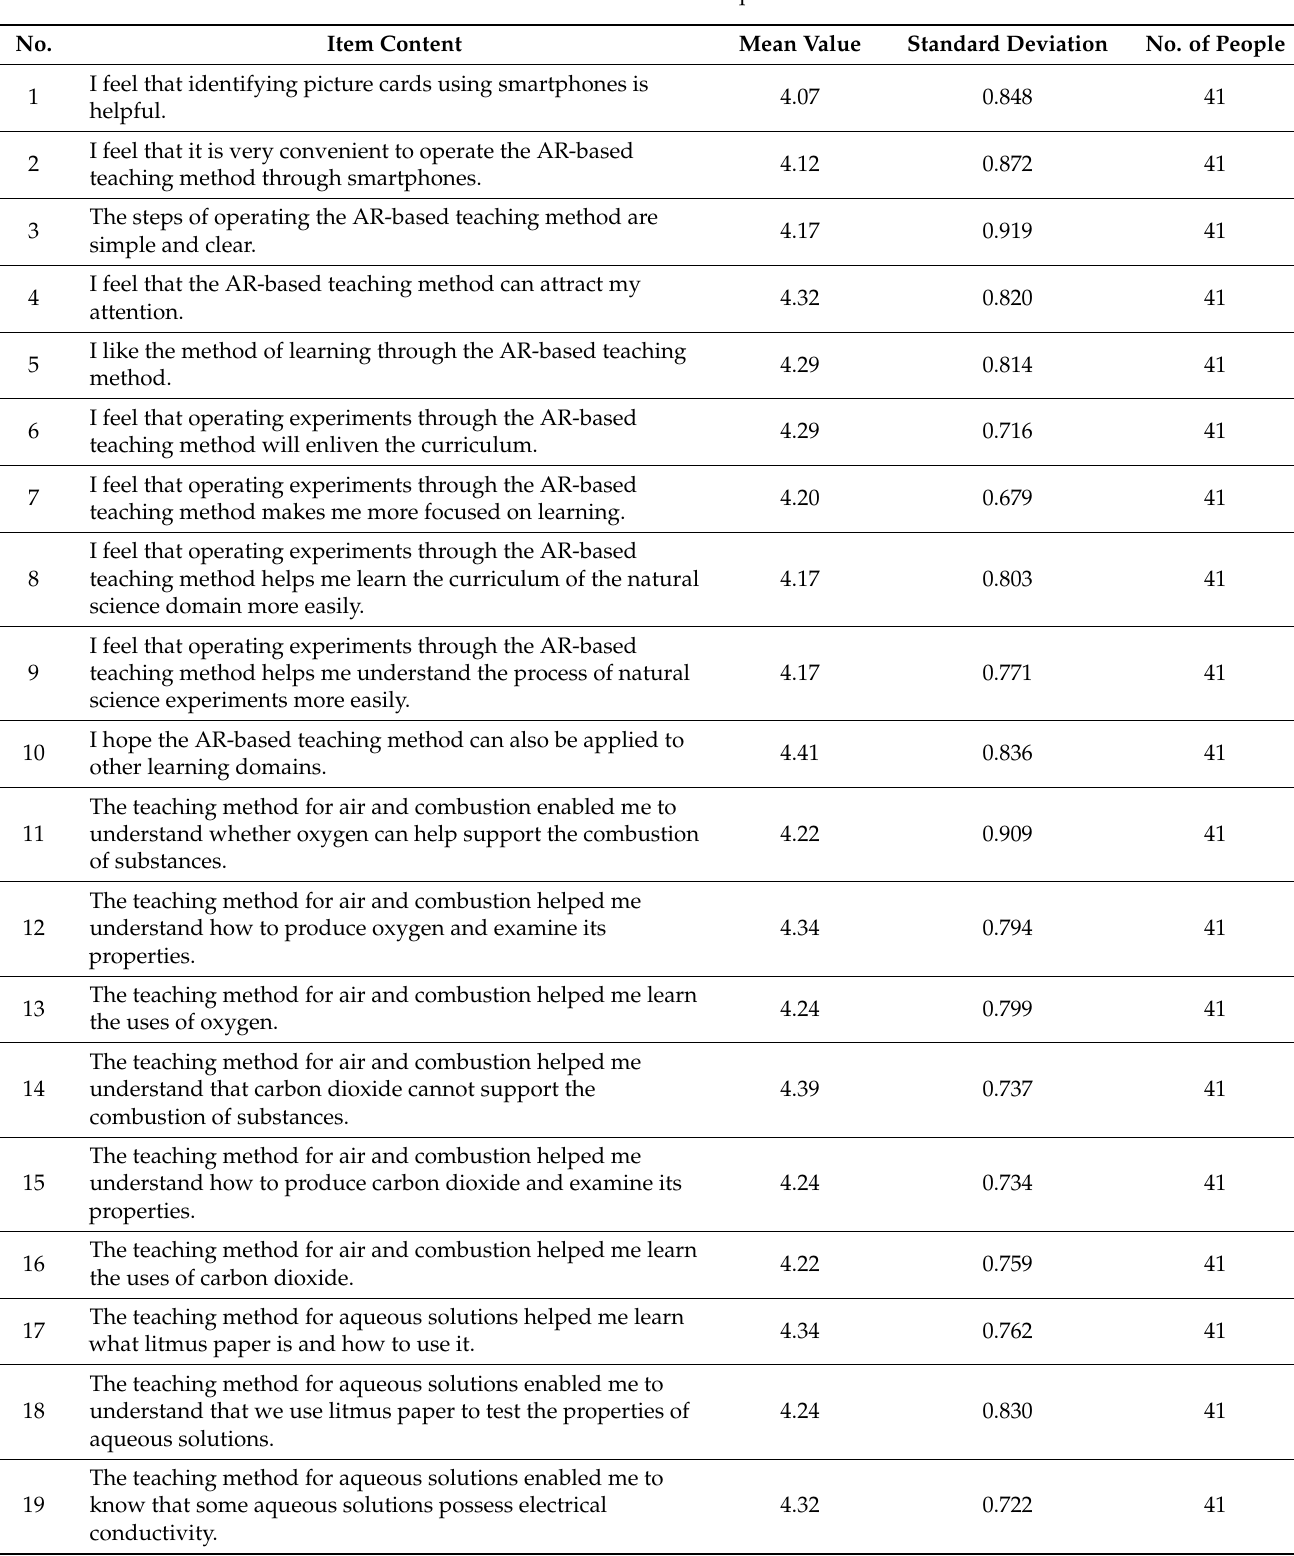
Table 12. Students’ satisfaction